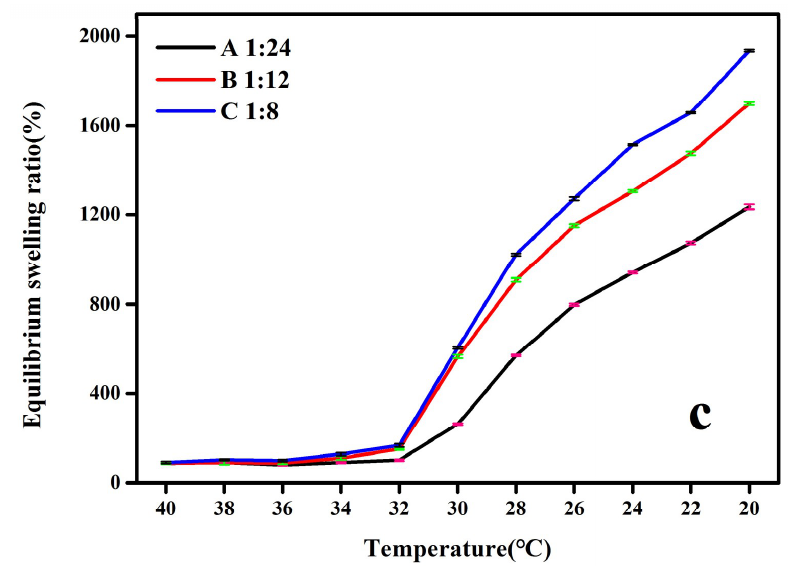
Figure 7. The swelling and deswelling behavior. ( a ) Swelling ratio at 20 °C; ( b ) deswelling ratio at 40 °C; ( c ) swelling ratio in the temperature range from 40 to 20 °C.